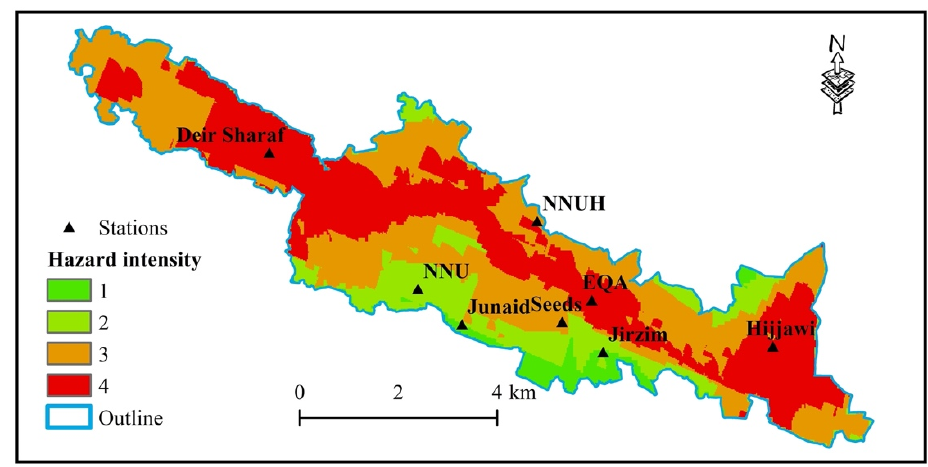
Figure 5. Hazard intensity map and locations of monitoring.